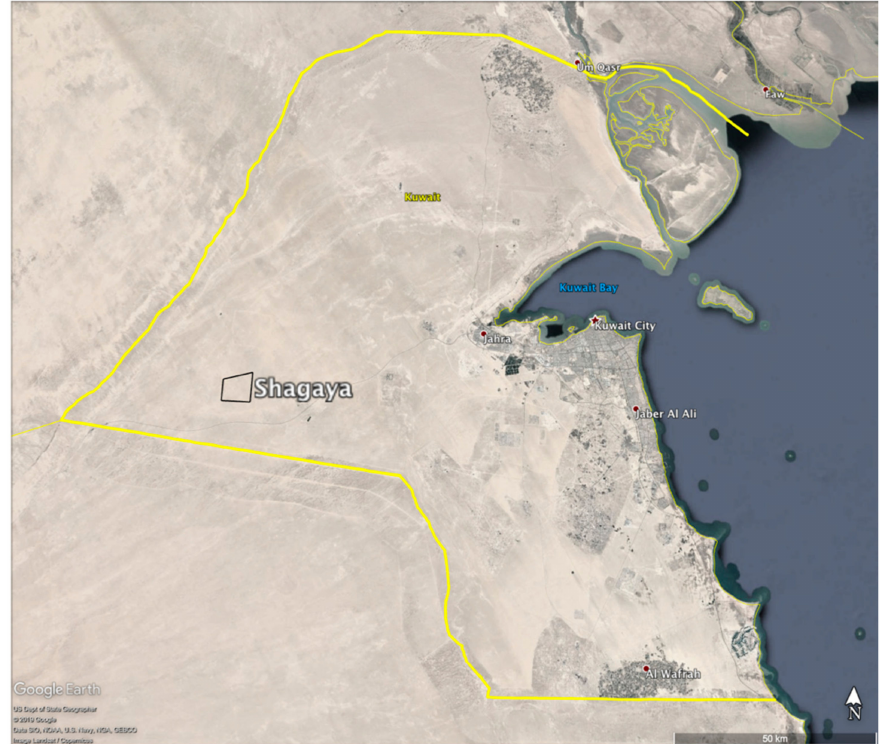
Figure 1. Map of Kuwait (yellow outline), with the Shagaya Renewable EnergyPark boundary (black polygon) in western